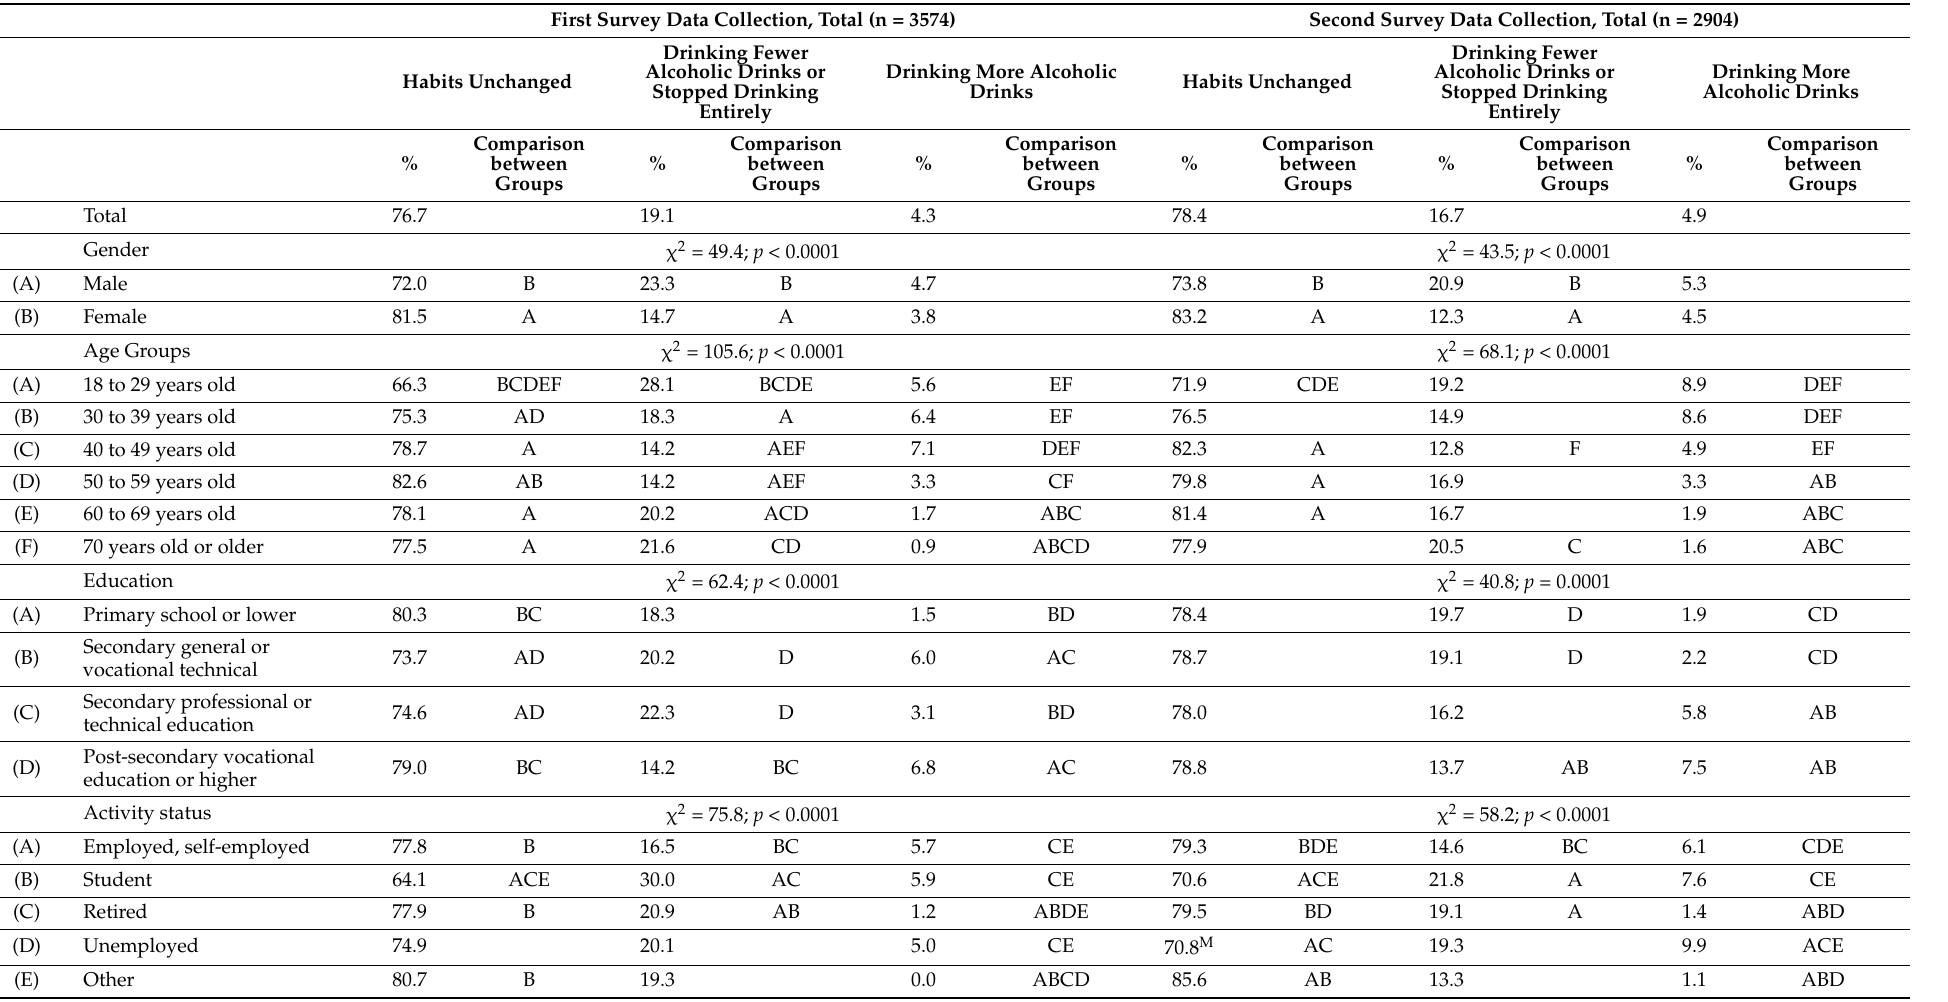
Table 1. Respondents who changed their drinking habits in the past 12 months and those who did not, reported in the first and second cross-sectional survey data collections; this includes the total and is according to the explanatory